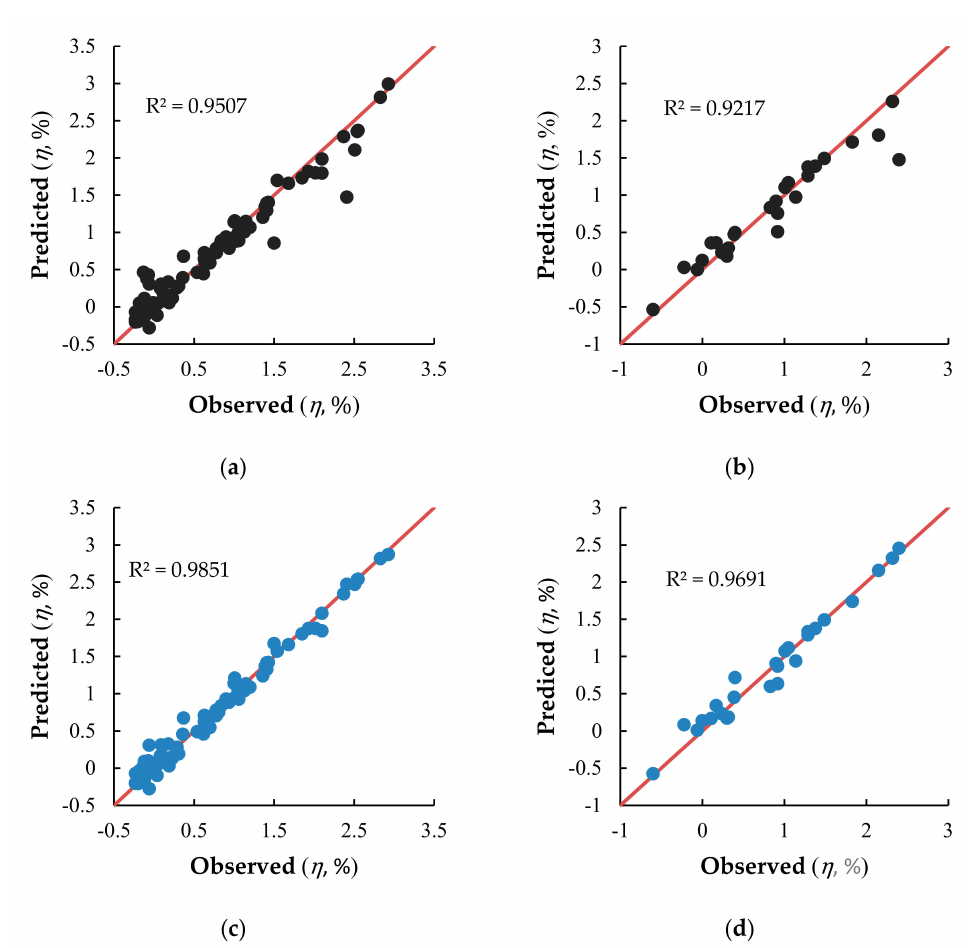
Figure 8. Relationship between observed and predicted η for the GRNN models: ( a ) training Single-GRNN, ( b ) testing Single-GRNN, ( c ) training Interact-GRNN, and ( d ) testing Interact-GRNN.